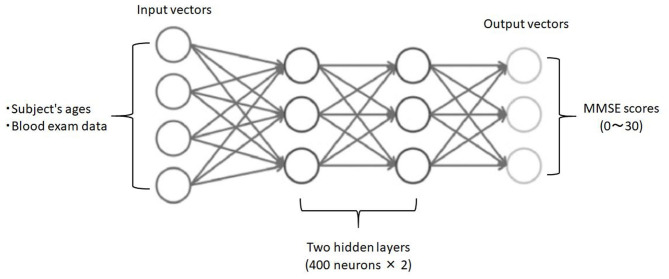
Schematic drawing of the DNN model for predicting MMSE scores. Input vectors include subject age and blood examination data. The output vector is a regression to estimate the MMSE score. The hidden layer contains no backward connections from the downstream layers.